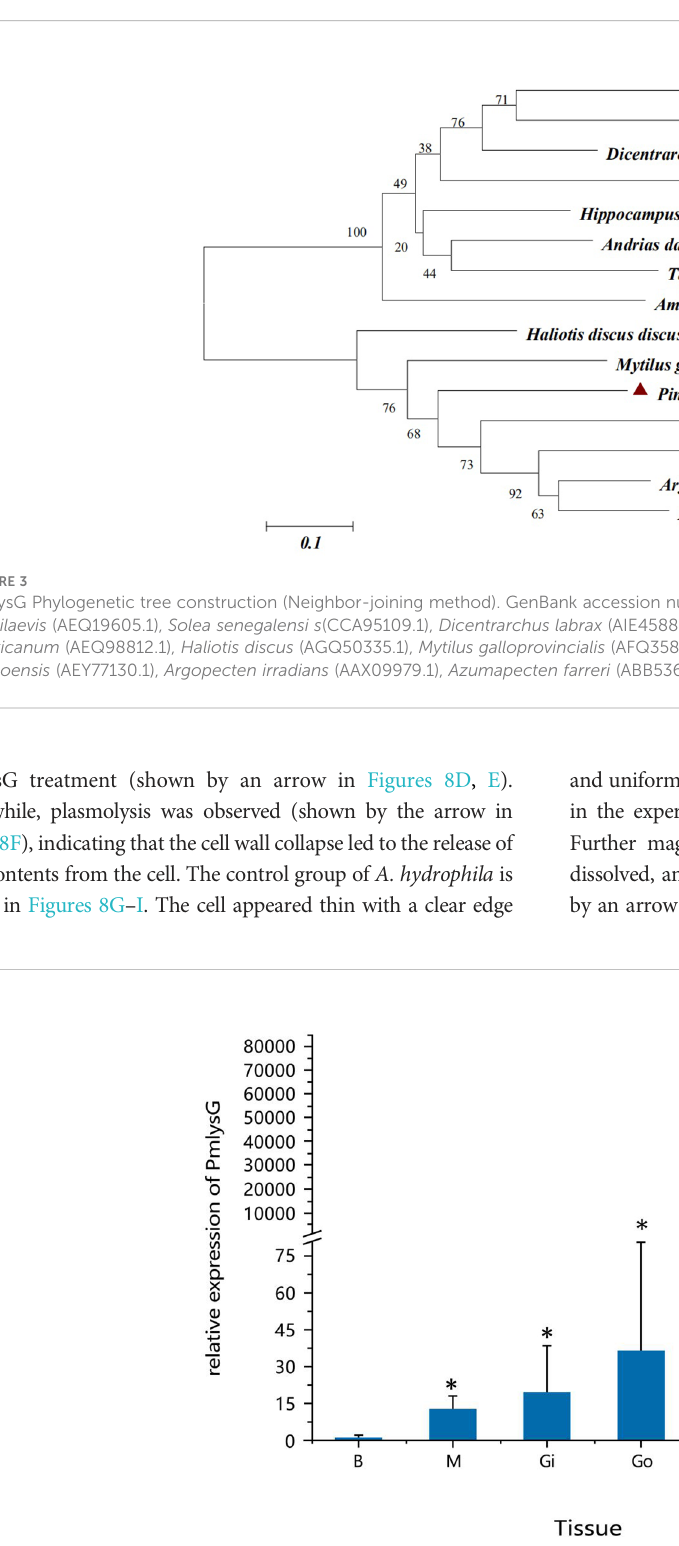
FIGURE 4 Quantitative analysis of PmlysG gene expression. He: Hepatopancreas, Gi: Gill, Go: Gonad, M: Mantle, H: hemocytes, A: Adductor muscle. *, P < 0.05; **, P <